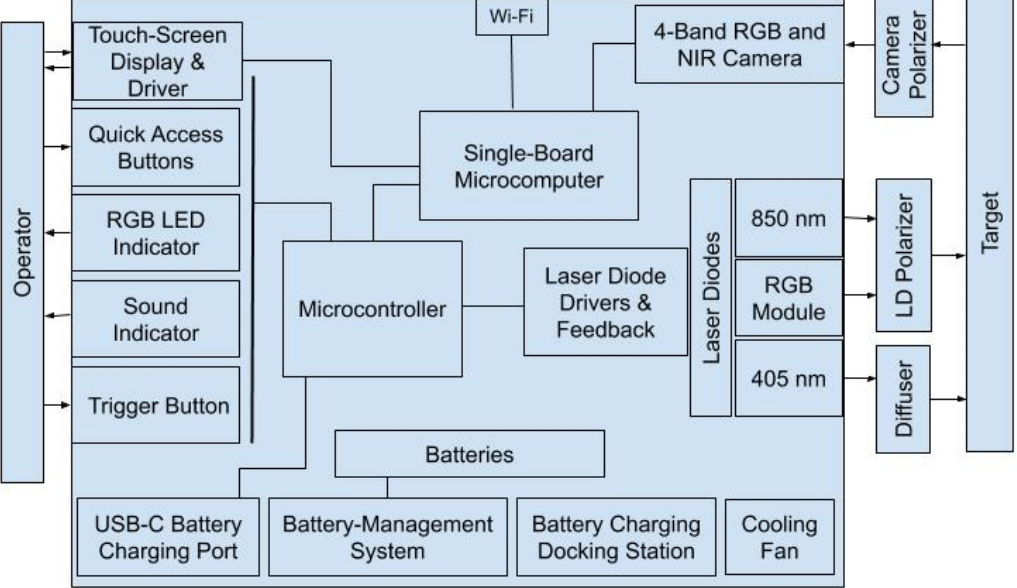
Figure 2. Block-diagram of the device.